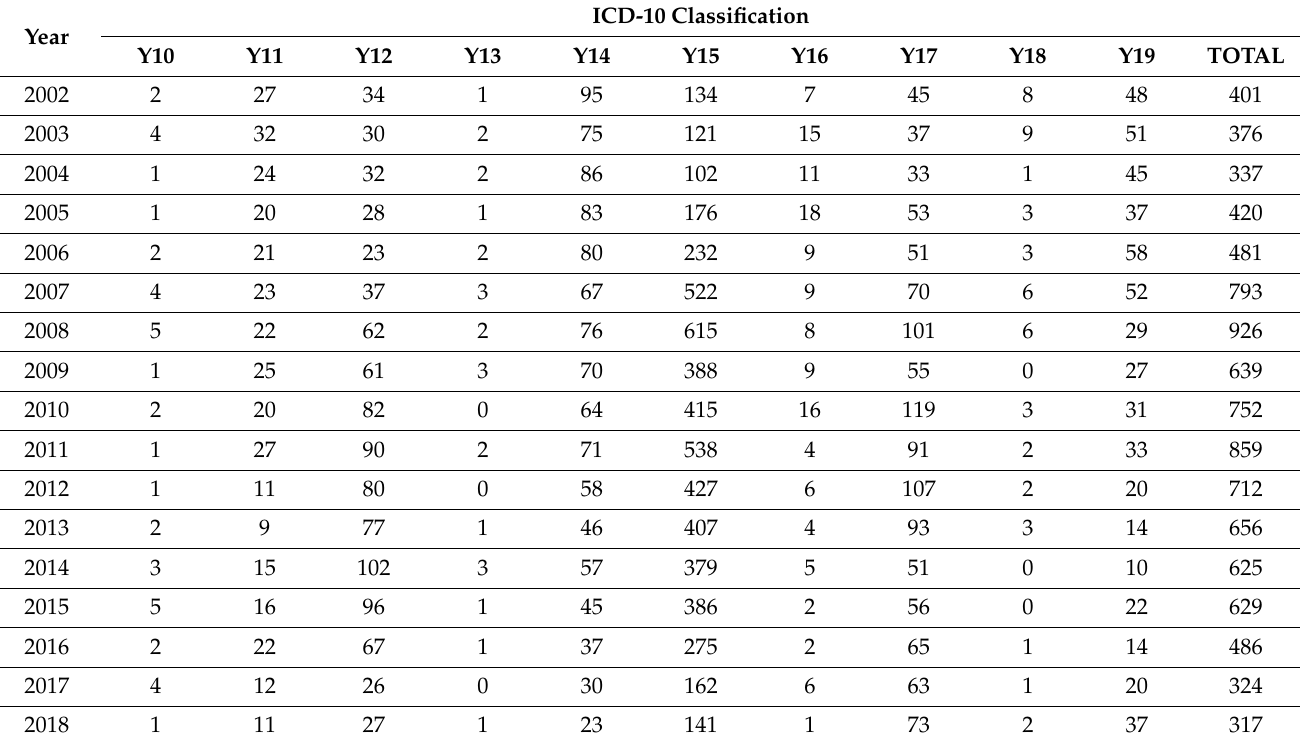
Table 6. Number of deaths in the category: undetermined intent (suicide) X60–X69 according to ICD-10, in 1999–2020 in Poland (source: own study based on data by